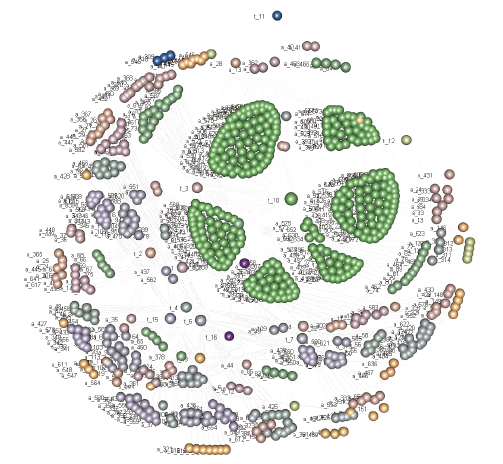
Figure 9: Layer T of the network de fi nes the types of activities. The six clusters formed in this layer re fl ect the e ff ects of how the activities are distributed among the zones (de fi ned by layer Z), which illustrates the bene fi t of the multidimensional network- based visual exploration of the production